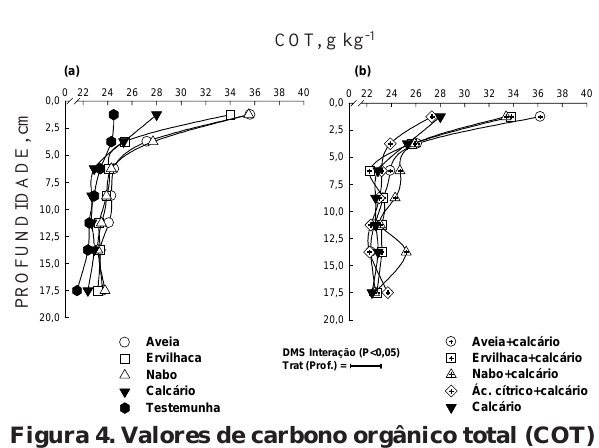
Figura 4. Valores de carbono orgânico total (COT) no perfil do solo, após 60 dias da aplicação superficial dos resíduos, isolados (a) e junto com calcário (b), em colunas indeformadas, coletadas em área de plantio